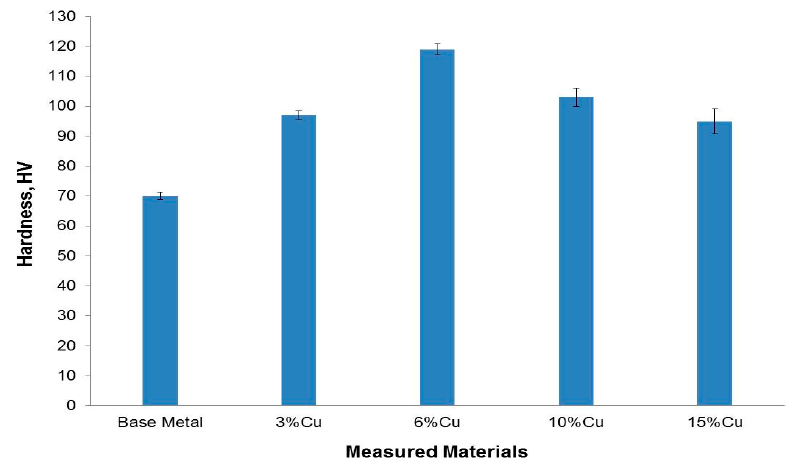
Figure 6. Average hardness measurement values of the Al-12% Si base metal and the formed composites after the addition of copper powder with different weight percentages.